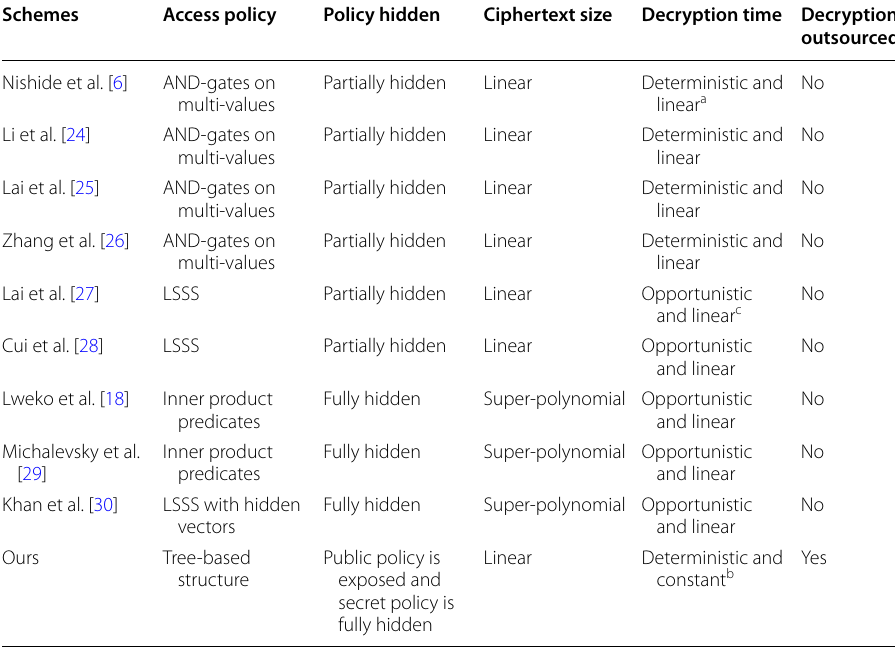
Table 1 Comparison of CP-ABE schemes with hidden